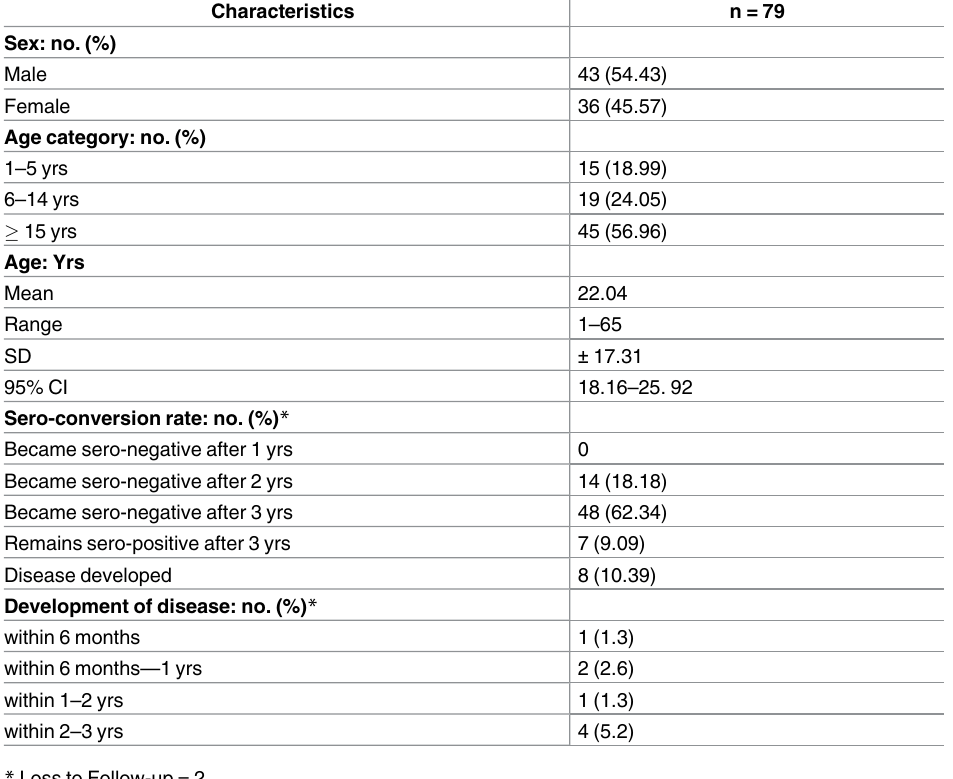
Table 1. Demographic parametersof asymptomatic rK39 positive cases.